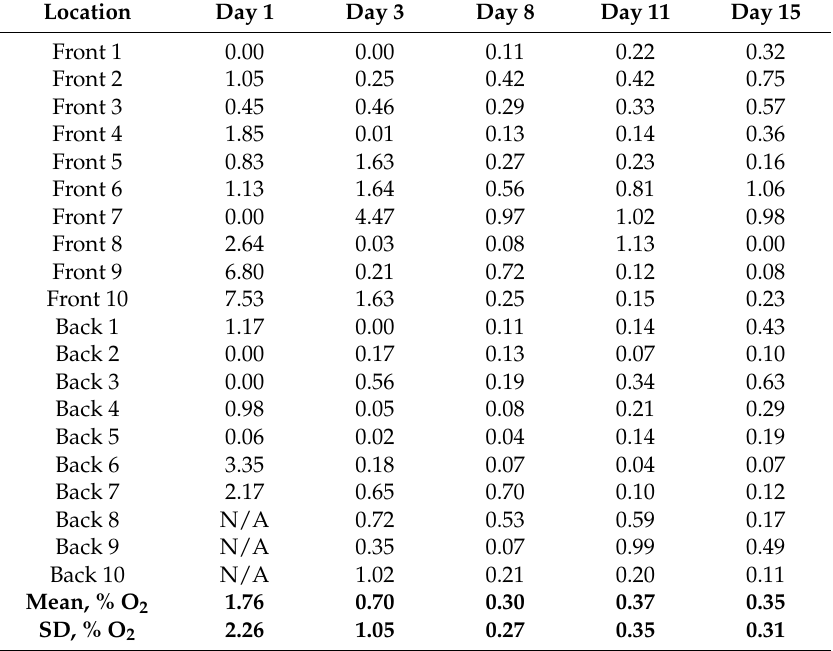
Table 1. Residual O 2 level readings (%) for each sensor contained in Bin 1 over a 15-day storage